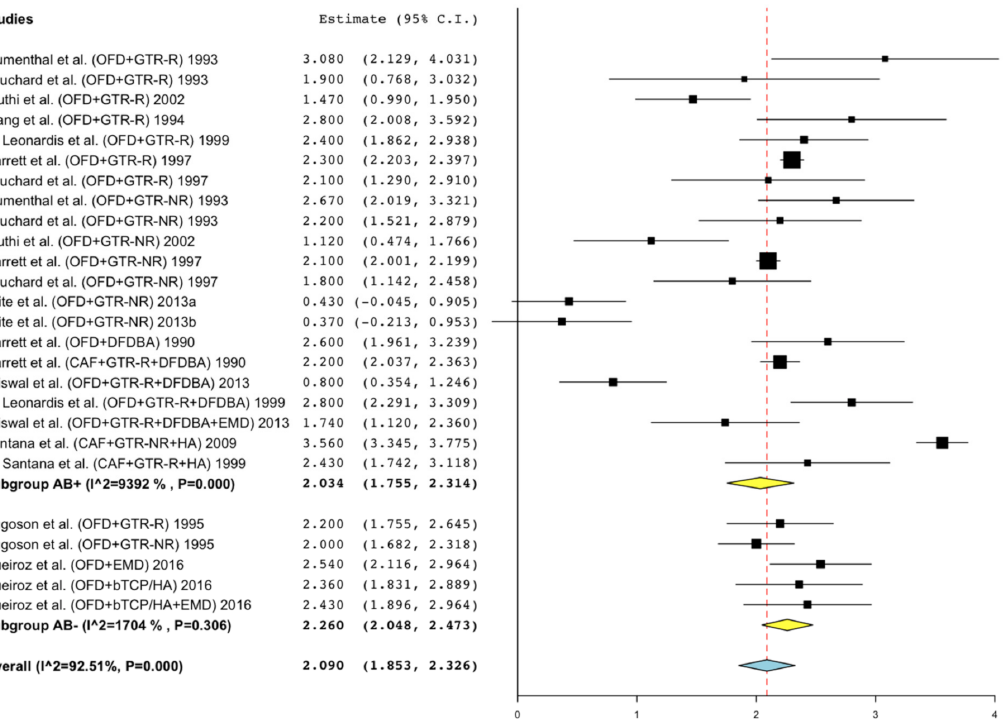
Figure 2. Forest plots of single-arm meta-analyses for PPD reduction for studies of regenerative techniques in furcation defects with or without adjunctive antibiotics.